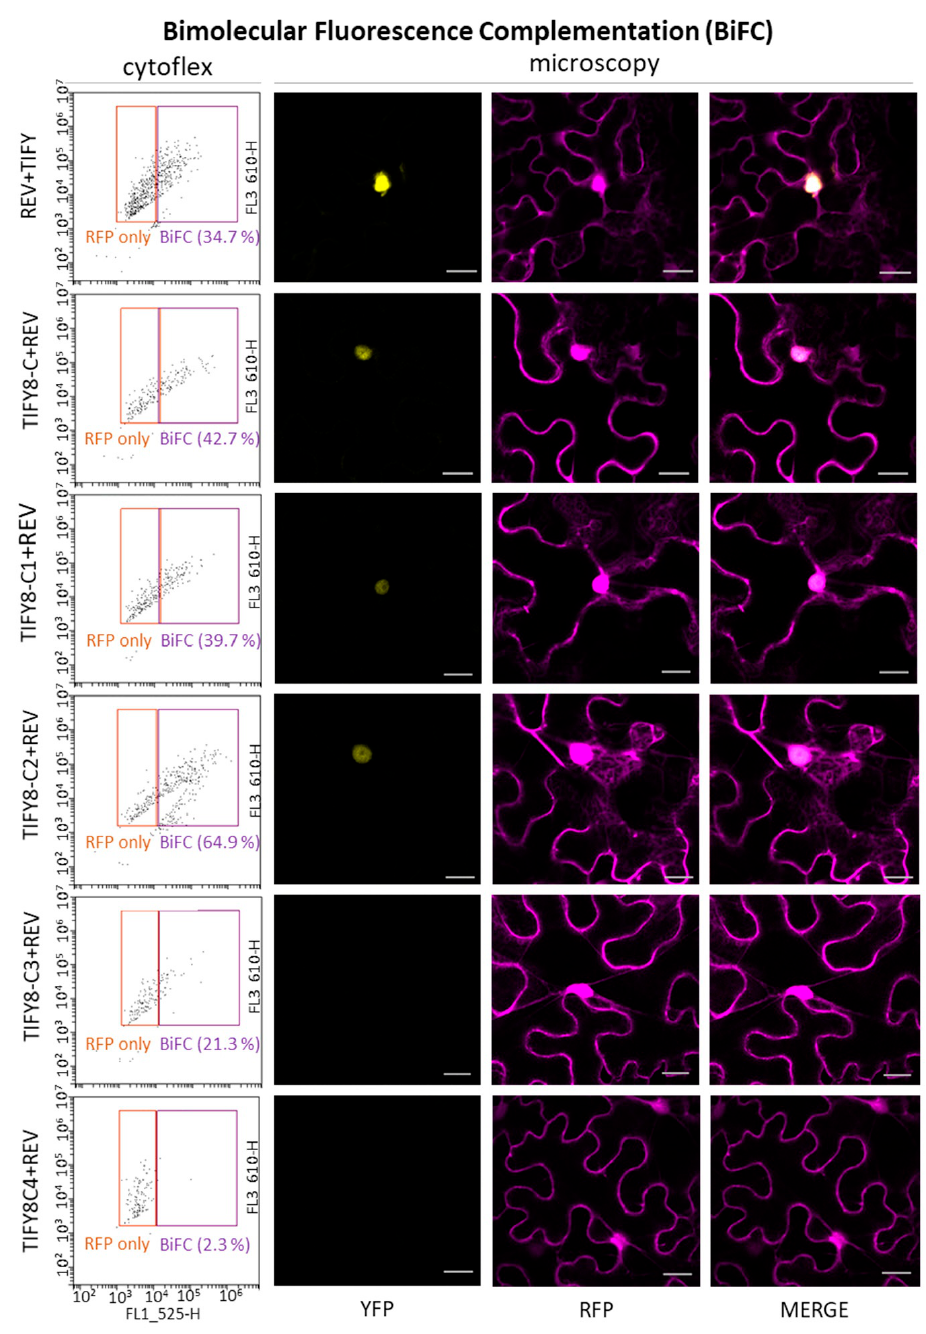
Figure 2. In planta protein–protein interaction between TIFY8 or TIFY8-truncated versions (see Figure 1a) with REV using BiFC in transiently transformed Arabidopsis protoplasts or tobacco leaves. Protoplasts were analyzed with the cytoflex cell sorter ( left ), orange squares indicate transformed protoplasts (RFP), and purple squares indicate interaction via BiFC (YFP). Transiently transformed Nicotiana benthamiana leaves were analyzed under the confocal laser scanning microscope ( right ). YFP indicates BiFC; RFP is used as a transformation control. Scale bar indicates 20 µm.